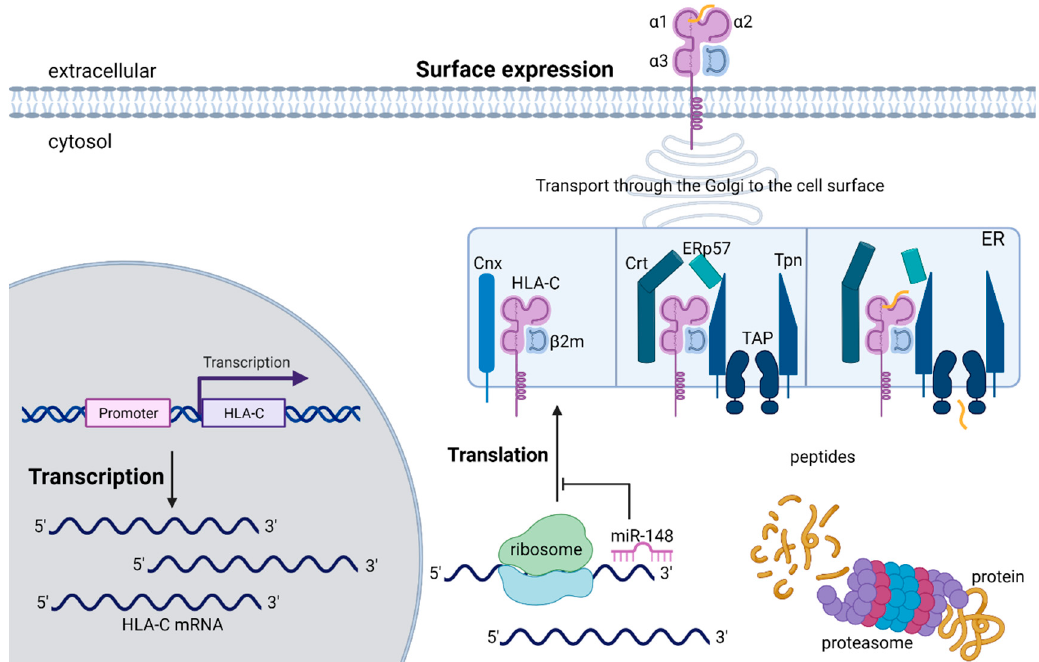
Figure 2. Protein synthesis pathway of HLA-C. Transcription of HLA-C is regulated through various transcription factors in the promoter region. Once the HLA-C mRNA is translated, the generated polypeptide undergoes proper folding, assembly and peptide loading. Translation of the HLA-C mRNA is regulated by micro-RNA-148 (miR148), which binds to the 3’ untranslated region. The assembly of the HLA-C heavy α -chain with β 2m and a peptide is facilitated by a multi-